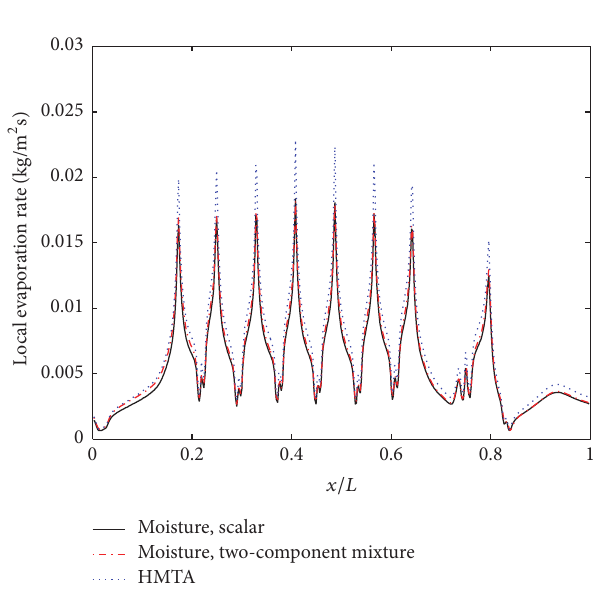
Figure 5: Local evaporation rate as a function of normalized distance from sheet entrance.